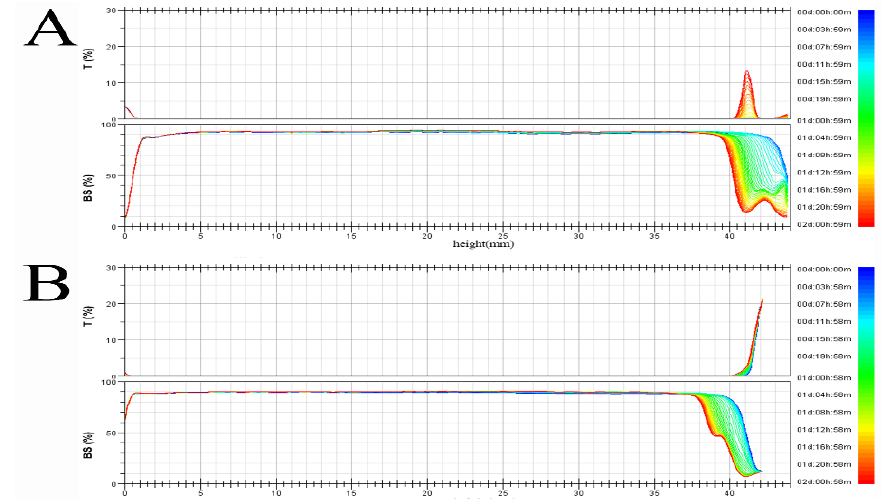
Figure 1. Backscattering and transmitting light intensity variation for two pyraclostrobin suspension systems with time. ( A ) pyraclostrobin crystal II, ( B ) pyraclostrobin crystal IV.